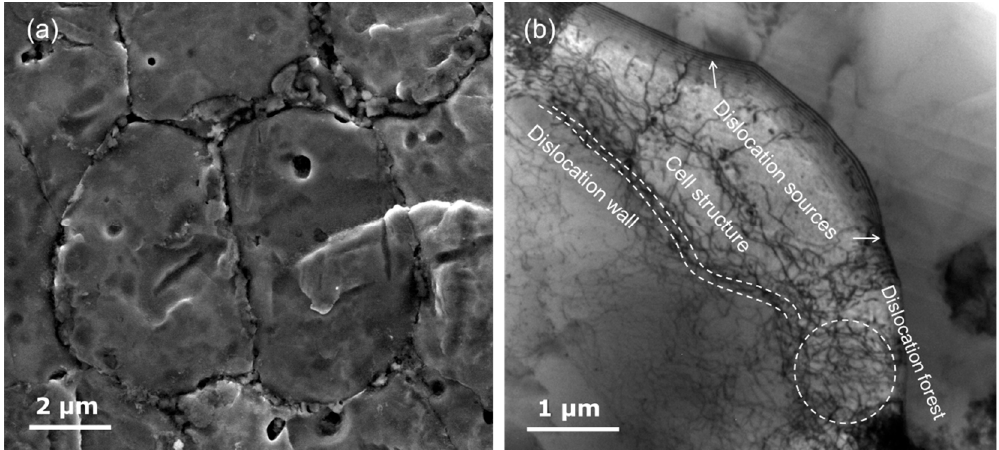
Figure 6. ( a ) Typical microstructure of the aluminum specimen sintered by UAS. ( b ) TEM image of the aluminum specimen with high density of dislocations.